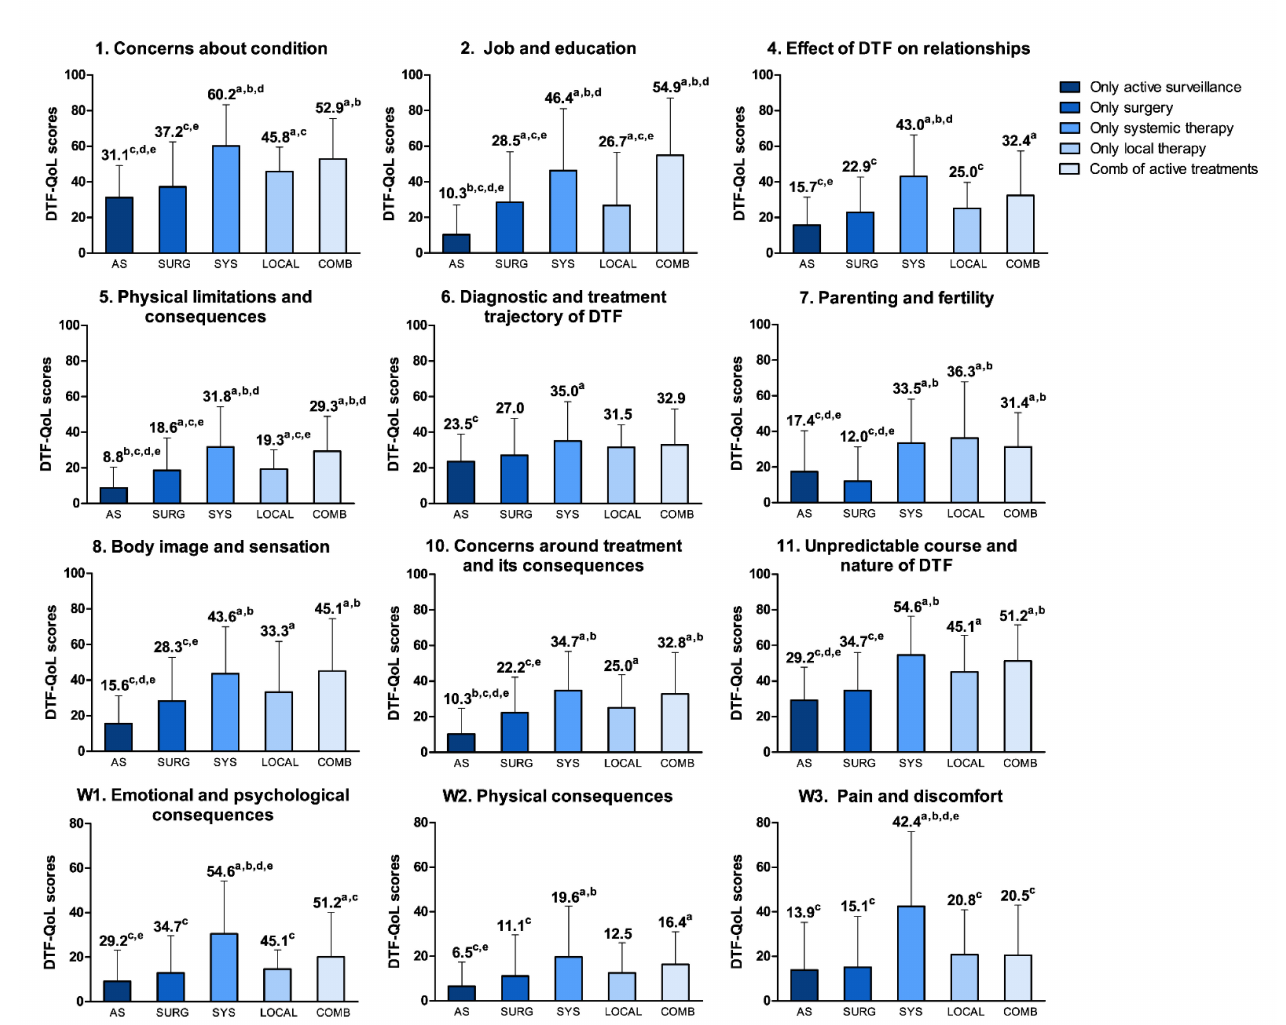
Figure 1. Mean DTF-QoL scores per treatment type. Differences in mean scores of DTF-QoL